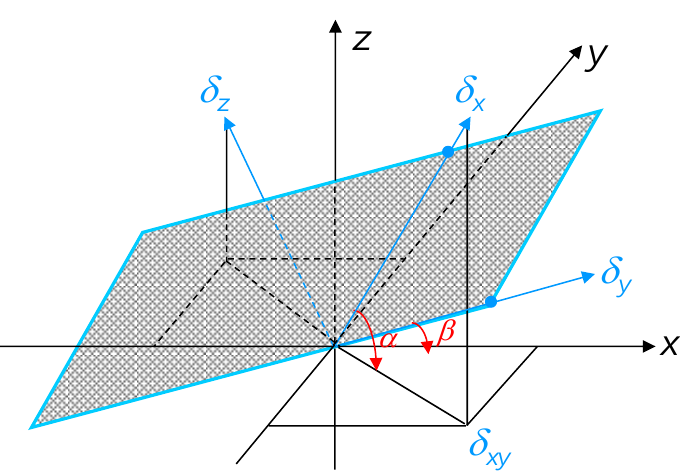
Figure 1. Schematic of calculation model considering dip and azimuth.